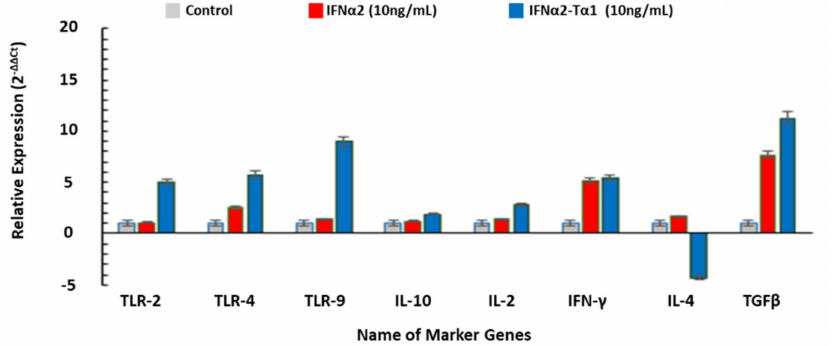
Figure 8. Relative expression of TLR-2, -4, -9 and other immune modulators such as IL-10, IL-2 IFN- γ , IL-4 and TGF- β in IFN α 2–T α 1 and IFN α 2-treated cells. These data are presented as means of triplicate PCR experiments. Data are represented as Mean ± SD (n = 3, two-way ANOVA, p < 0.05 considered significant with 95%